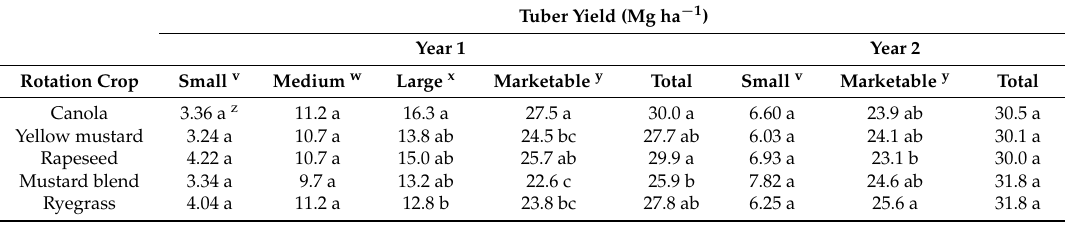
Table 5. Average potato tuber yield in various size classes in addition to marketable and total yield as affected by previous rotation crop treatments at the Central Aroostook site in potato Years 1 and 2.